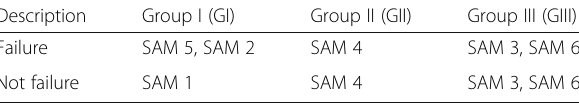
Table 2 Sample groups based on percentage of fine and coarser particle and, failure